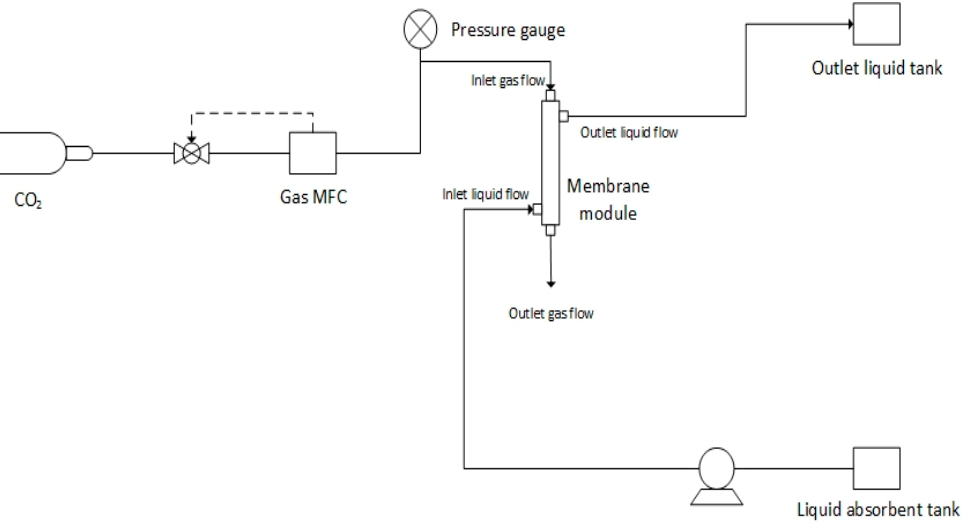
Figure 1. Schematic drawing of the MGA setup.